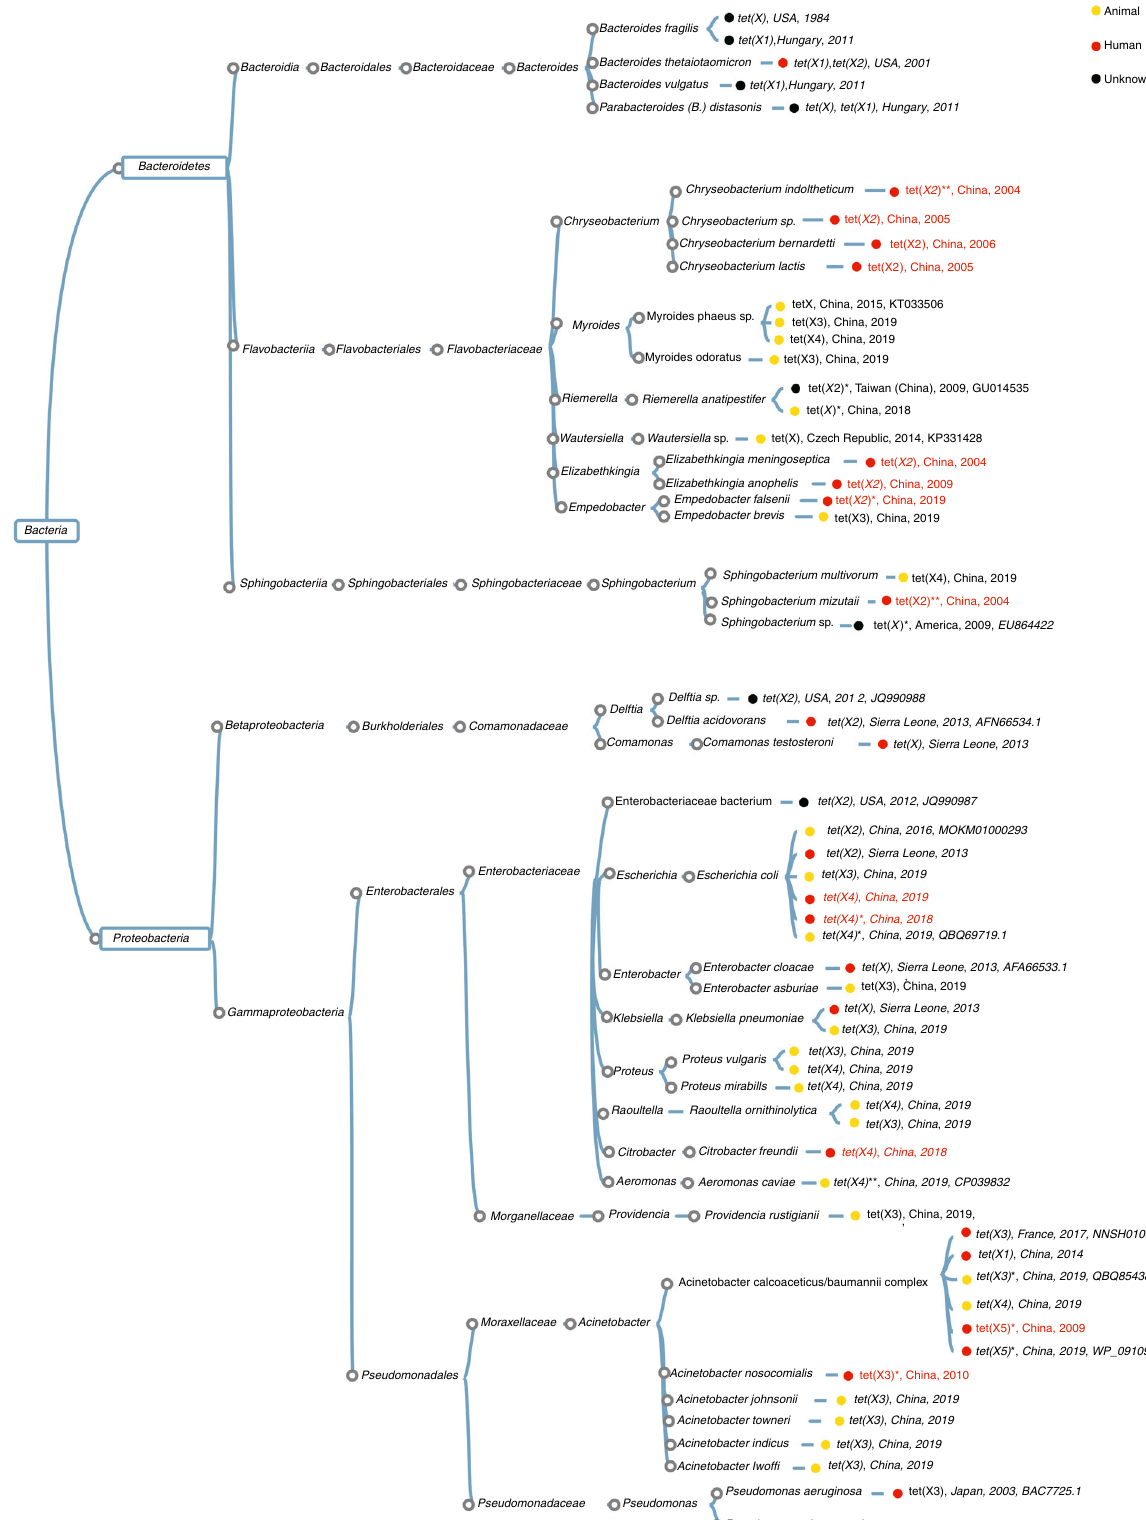
Fig. 3 Taxonomy of Tet(X)-producing isolates analyzed in this and previous studies. Asterisks (*) and (**) represent the location of the tet (X) gene in plasmid and chromosome, respectively. Text in red fonts depicts tet (X)-positive isolates tested in this study, and information of isolates with black fonts were retrieved from the literature (Supplementary Data 2). Strains isolated from different sources are shown by circles in different colors (human, red; animal, yellow; unknown, black). Year at the end of each branch denotes the year in which the fi rst strain of the related taxonomy was